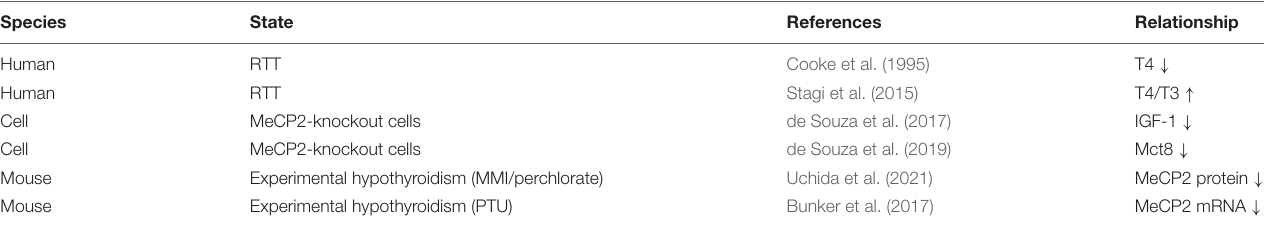
TABLE 4 | Thyroid function disorders and